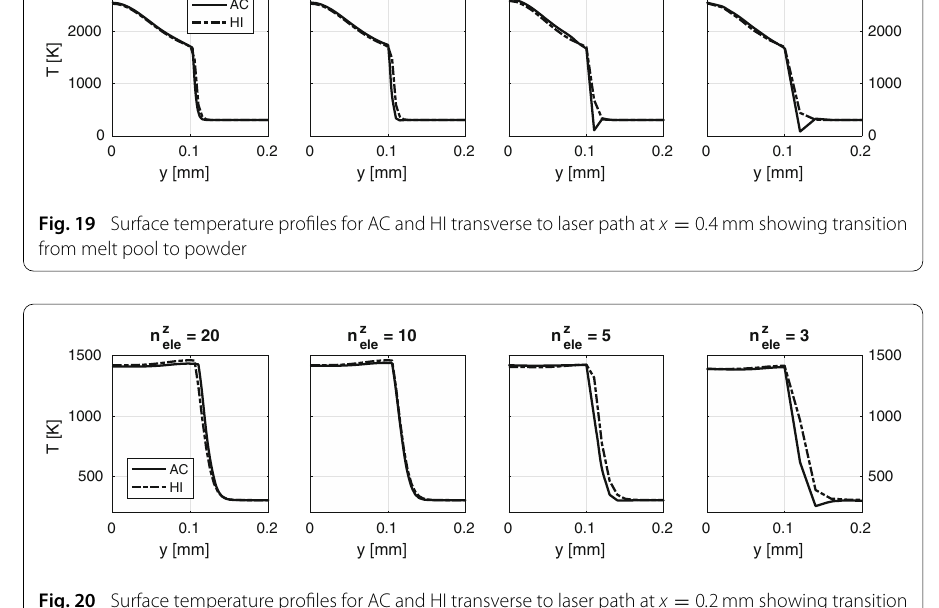
Fig. 20 Surface temperature profiles for AC and HI transverse to laser path at x = 0 . 2mm showing transition from solid to